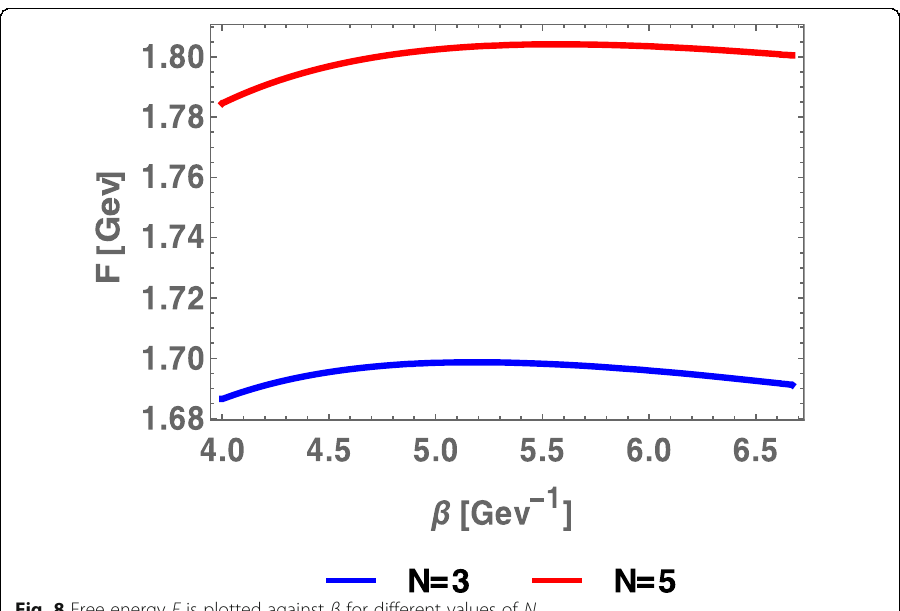
bottomonium, b c ; and c s mesons increase with the increasing dimensional number